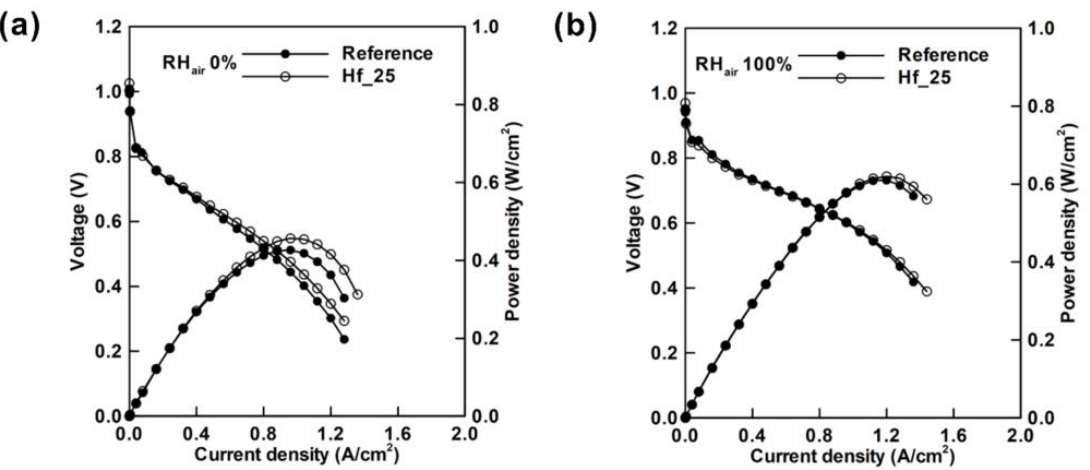
Figure 12. ( a ) Schematic of the 3D-printed GDL, ( b ) a SEM image of the microstructure of the i-FF-GDL, and ( c ) comparison of the performance of the fuel cells using 3D-printed i-FF-GDL and traditional anode configuration. Reproduced with permission [105]. Copyright 2021, Elsevier.